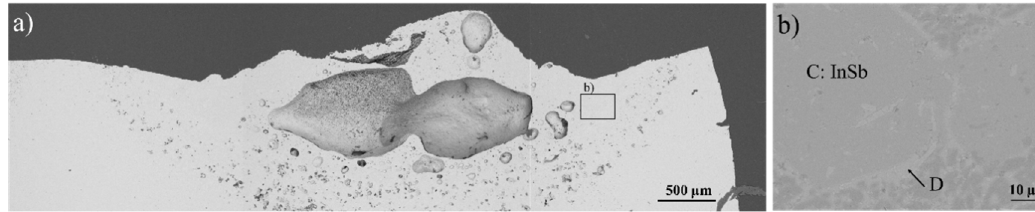
Figure 4. ( a ) SEM-EDS micrograph (BSE) of the cross-section of Fe100_SPS after interaction with AgCuIn. ( b ) and ( c ) SEM-EDS (BSE) magnifications of two selected areas indicated by rectangles in ( a )